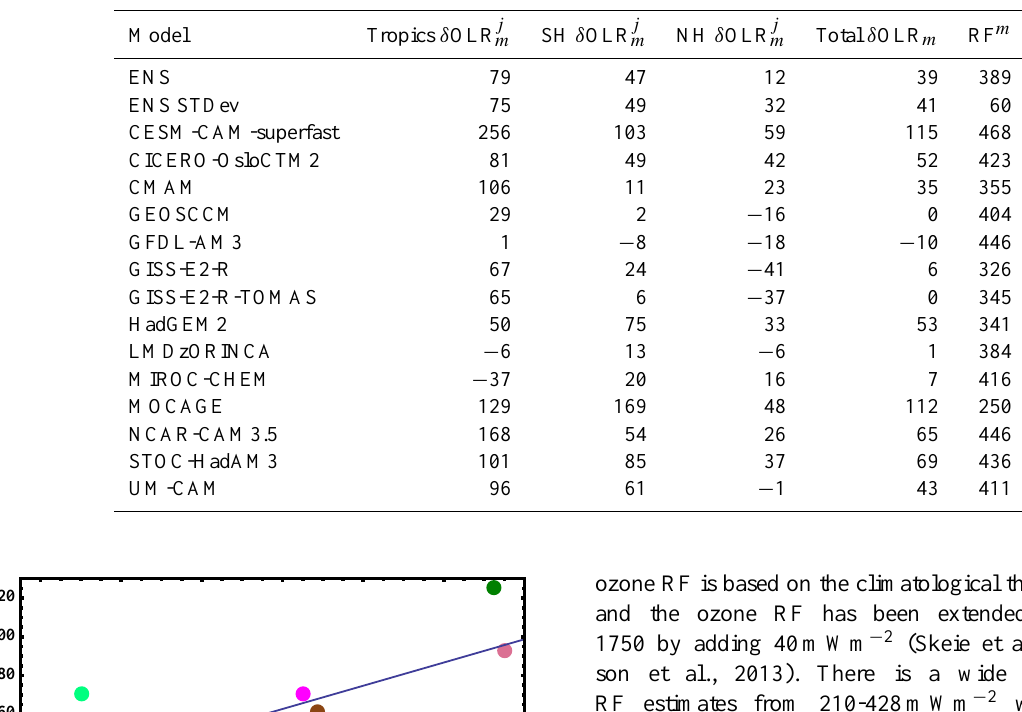
Table 1. ACCMIP OLR bias from tropospheric ozone ( δ OLR j m ) and ozone radiative forcing (RF m ) in mWm − 2 . The ozone RF m is taken from (Stevenson et al., 2013) and is defined relative to 1750 and at a climatological thermal tropopause. The ACCMIP ensemble mean and 1- σ are shown in the last column of the first two rows. Tropics are defined from 15 ◦ S–15 ◦ N.